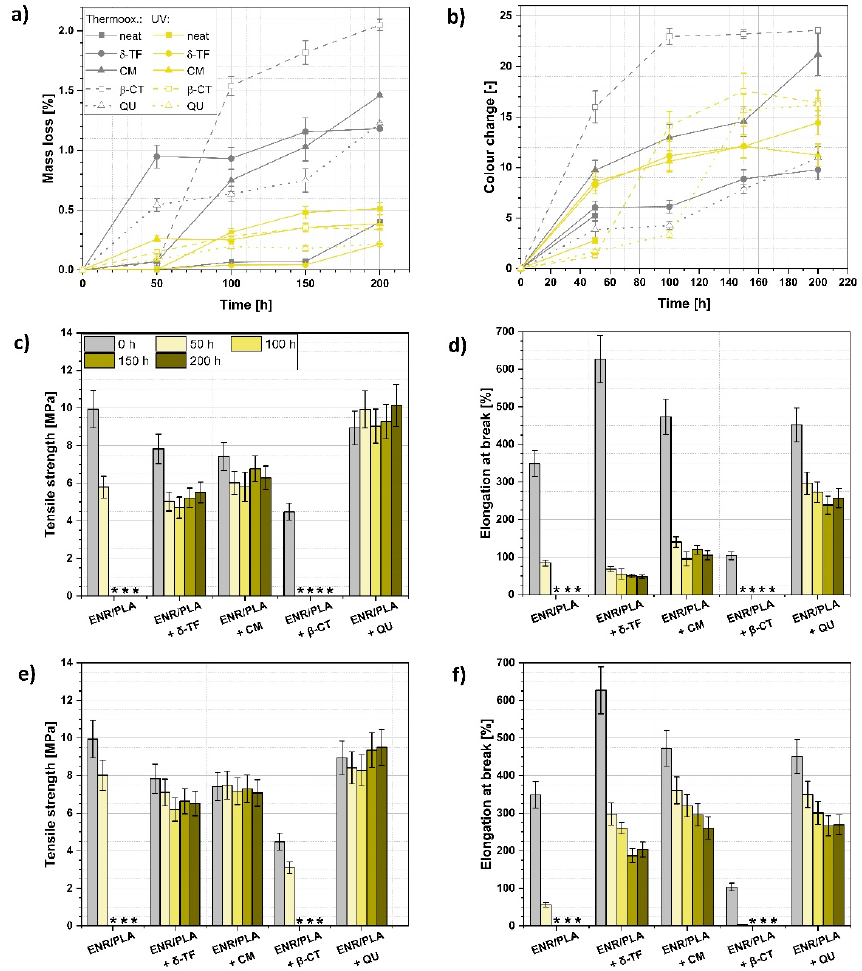
Figure 4. Investigation of the ENR/PLA blends’ properties before and after the accelerated aging processes: ( a ) mass loss during the thermo-oxidative and UV aging, ( b ) color change during the thermo-oxidative and UV aging, ( c ) tensile strength changes and ( d ) elongation at break variations during the thermo-oxidative aging, ( e ) tensile strength changes and ( f ) elongation at break variations during the UV aging. *—sample too brittle to be examined with the selected method; the measurement was impossible.